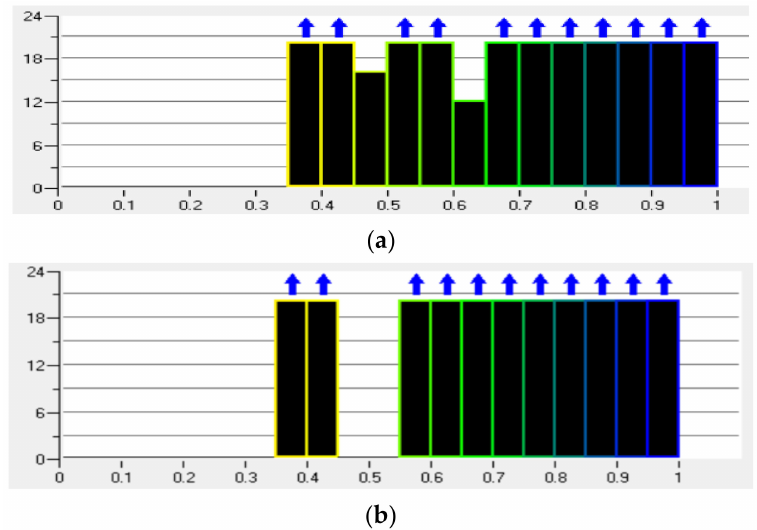
Figure 3. ( a ) Histogram of grid determinant. ( b ) Histogram of grid aspect